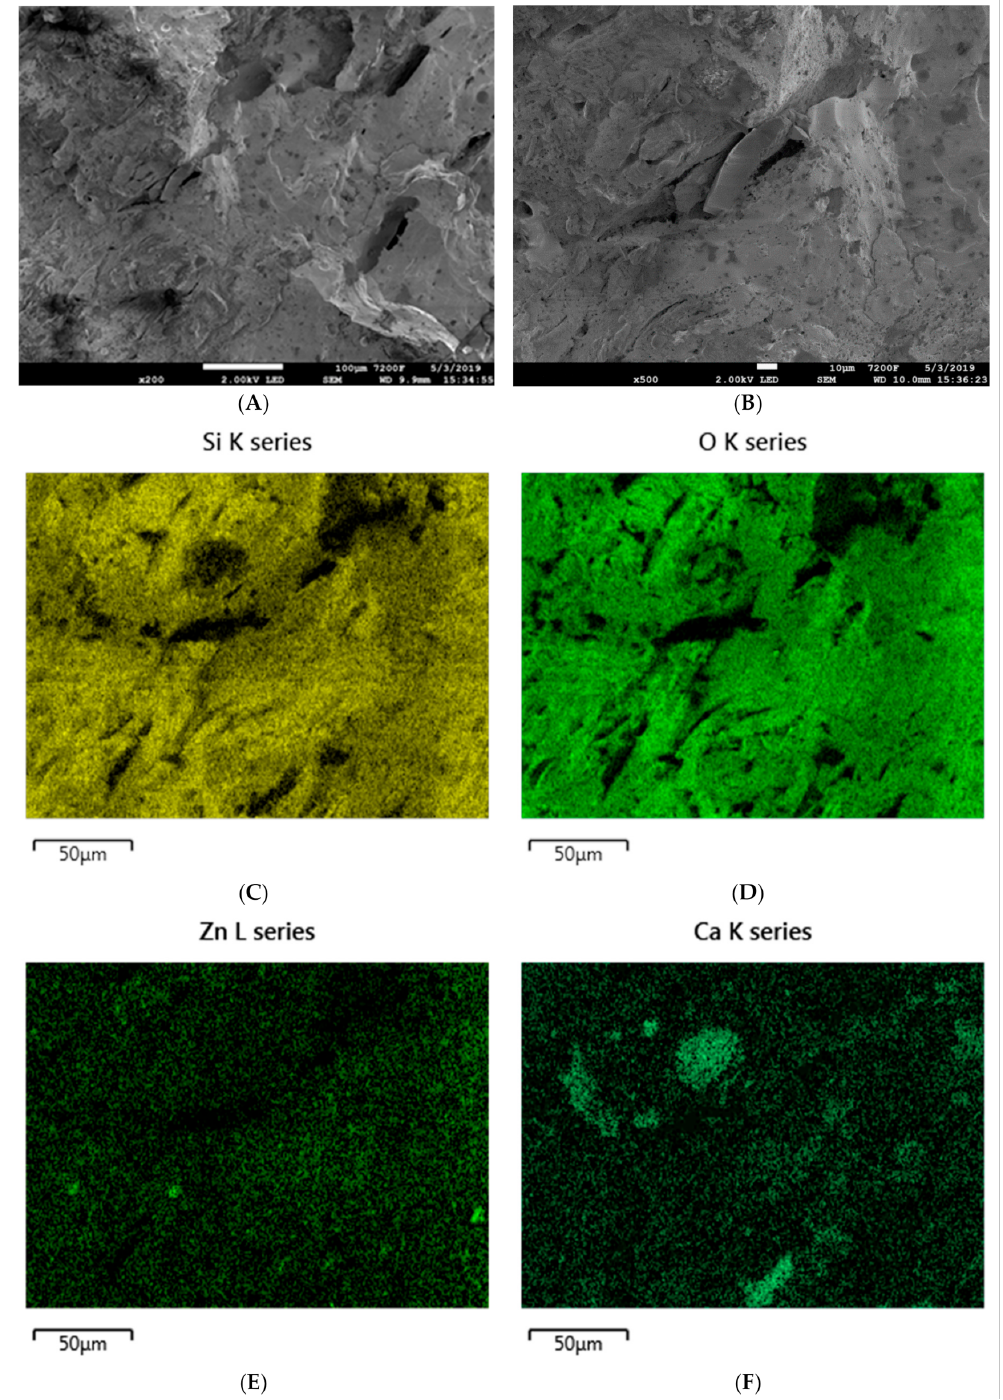
Figure 17. SEM images of the SR-6 composite after its ceramization At magnifications of ( A ) × 200 and ( B ) × 500. EDS mapping of SR-6 ( C ) silicon distribution, ( D ) oxygen distribution, ( E ) zinc distribution, and ( F ) calcium